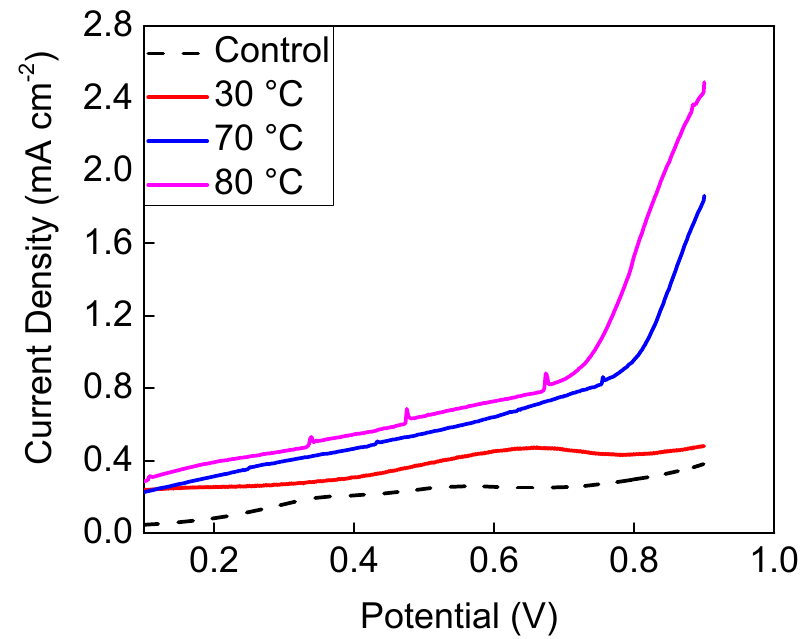
Figure 5. Polarisation curves recorded at 80 °C (pink trace), 70 °C (blue trace), and 30 °C (red trace) showing the behaviour of electrolysers using a commercial Fumapem membrane with an anolyte feed of 1 M NaOH containing 10 g L − 1 alkali lignin, alongside a control for the electrolyser using only 1 M NaOH at room temperature as the anolyte (black-dashed trace).